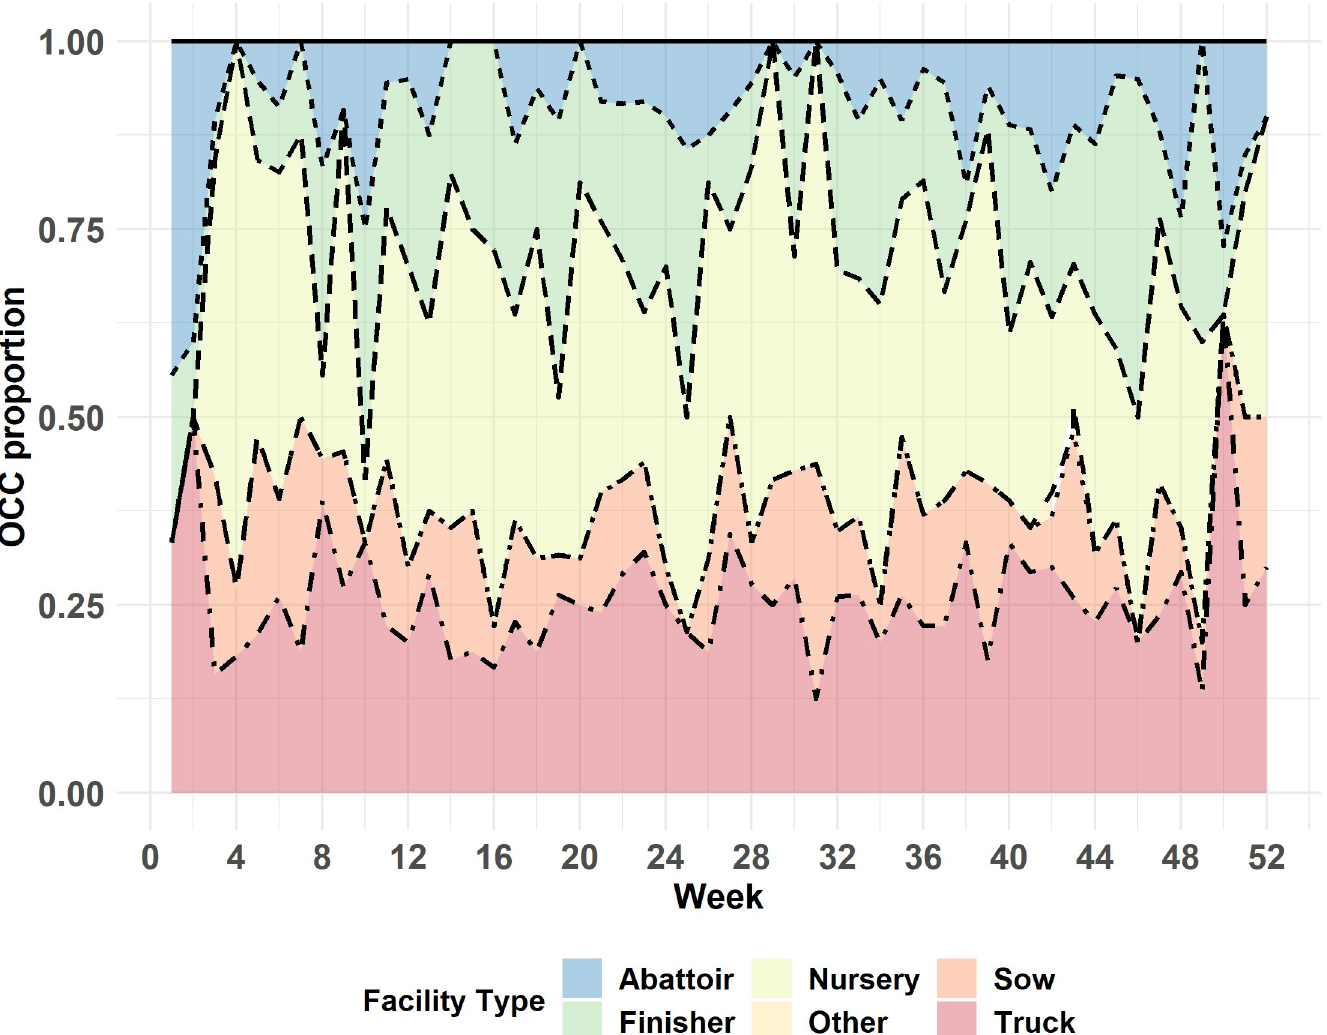
Fig 5. Proportional representation of each facility type within weekly maximum outgoing contact chain by week of the year, calculated on the basis of two-mode